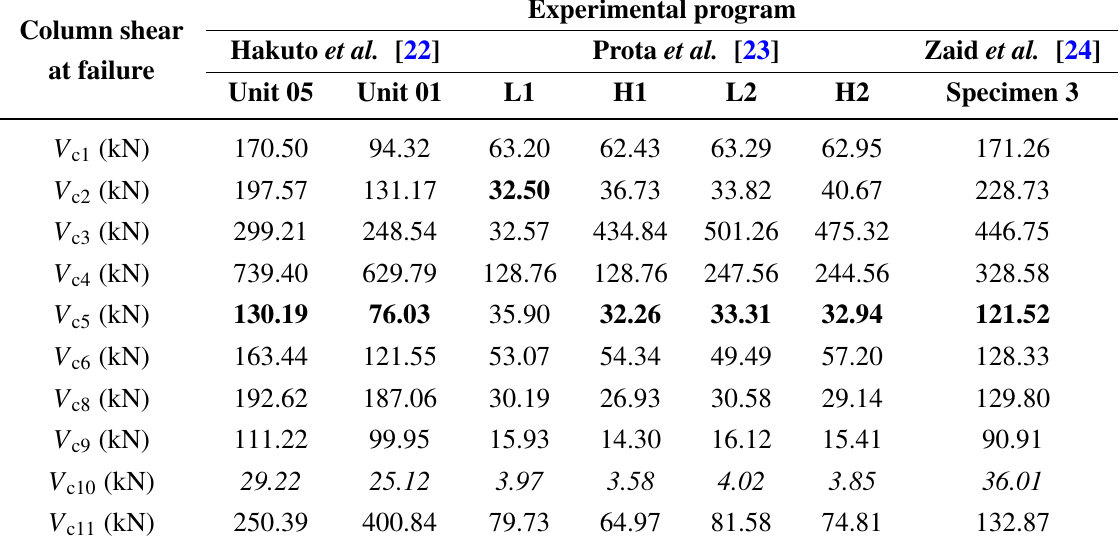
Table 5. Theoretical prediction of capacities for each potential failure modes of specimens of experimental programs.